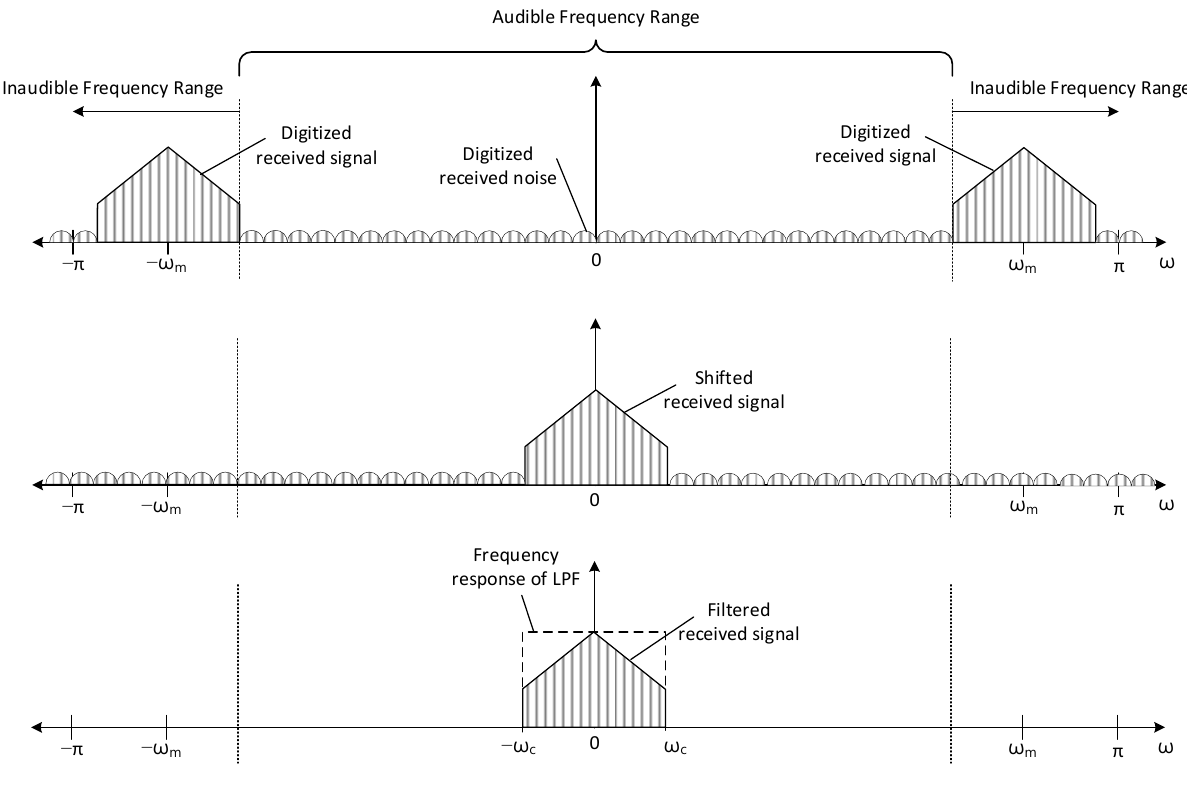
Figure 7. Frequency distribution of the individual receiver block.